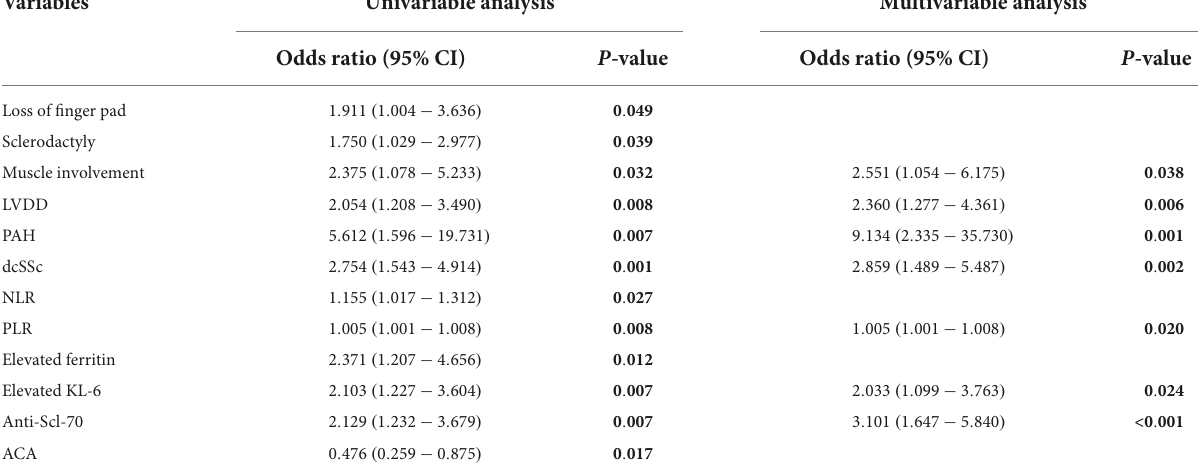
TABLE 3 Logistic regression analysis of clinical characteristics associated with the presence of ILD in